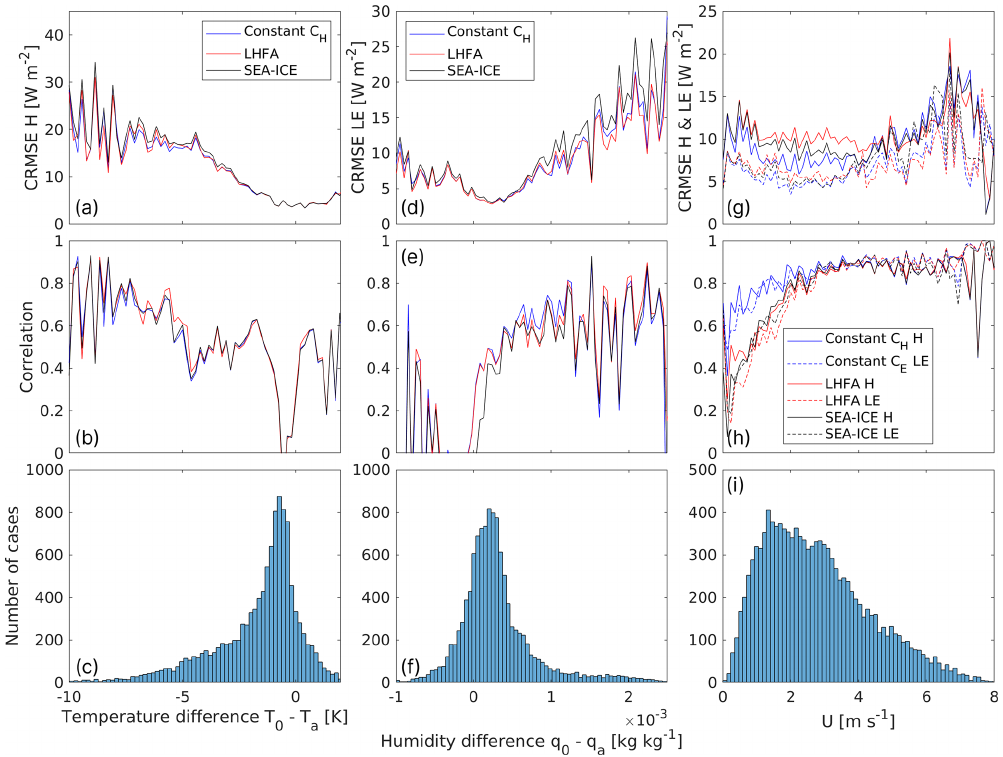
Figure 10. The centered root mean square error (CRMSE) (a, d, g) and correlation (b, e, h) of H (solid line) and LE (dashed line) for 100 equidistant bins of temperature difference, humidity difference and wind speed for each of the three models (blue for constant C H/E , red for LHFA and black for SEA-ICE). The lowest row of figures (c, f, i) shows histograms of temperature and humidity difference and wind speed